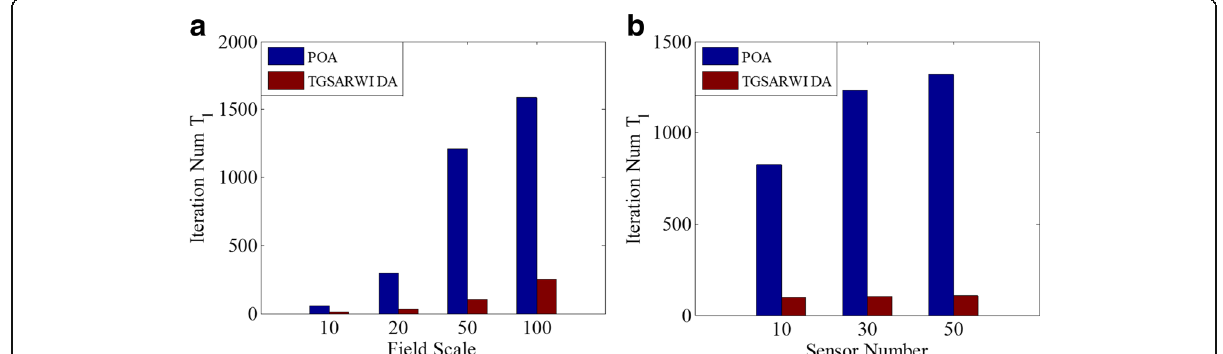
Fig. 12 Comparison of time computation complexity for POA and TGSARWI DA with different field scales and sensor number. a Shows the comparison of iteration number T l with the various field scales. b Shows the comparison of iteration number T l with the different sensor number